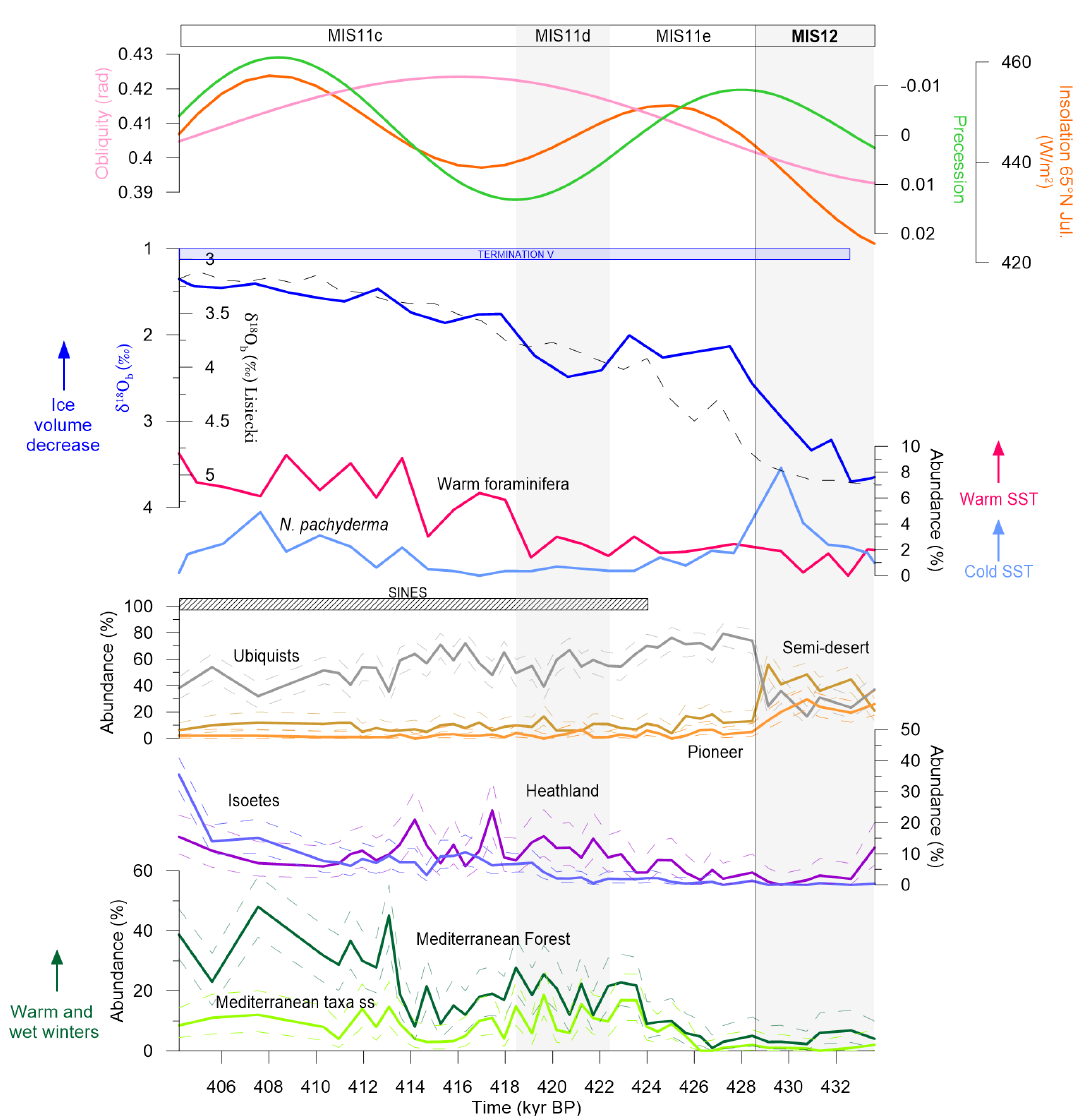
Figure 3. U1386-retrieved environmental indicators. From bottom to top: pollen percentages (this study), warm and cold foraminifera abundance (Moal-Darrigade et al., 2022a), δ 18 O b (from U1386 in blue line (Kaboth et al., 2017) and global in black dashed line (Lisiecki and Raymo, 2005)) and astronomical parameters (source: http://vo.imcce.fr/insola/earth/online/earth/online/index.php, last access: 23 June 2022). The dashed lines represent the 95% confidence intervals for MF, heathland and SD (computed with the “exactci” package, R). TV period defined by δ 18 O b variations is represented by the blue box, and the SINES regional terrestrial interglacial is indicated by the black hatched